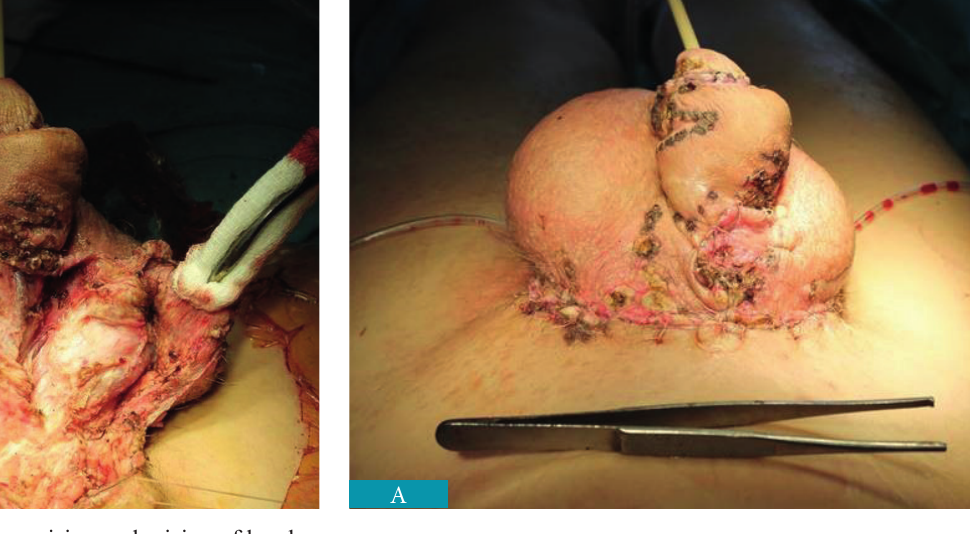
Figure 3 - View after local wide excision and raising of local fascio-cutaneus flap.